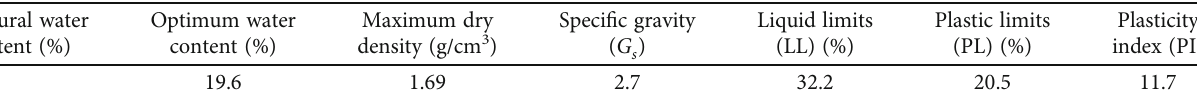
Table 1: Main physical parameters of loess.